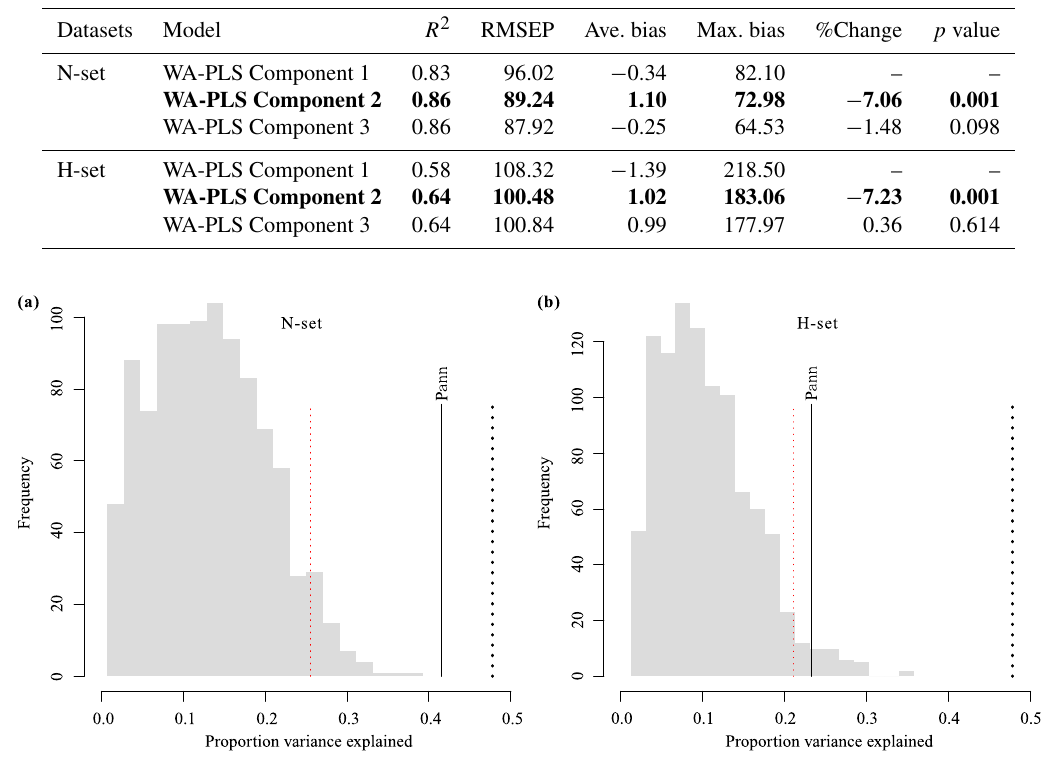
Figure 5. Proportion of variance (solid lines) in Gonghai Lake fossil pollen data explained by annual precipitation ( P ann ) transfer functions with (a) the natural set (N-set) and (b) the human-induced set (H-set). The thick black dotted lines indicate the proportion of variance explained by the first axis of a principal components analysis (PCA), and the fine red dotted lines indicate the 0.05 significance level. Histograms show the amount of variance explained by 999 transfer functions with random